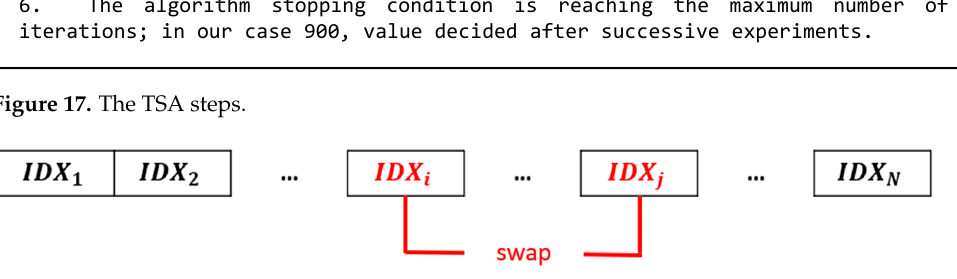
Figure 18. The generation of a neighboring solution.